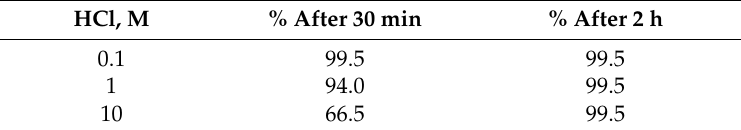
Table 7. Influence of initial HCl concentration on gold(III)